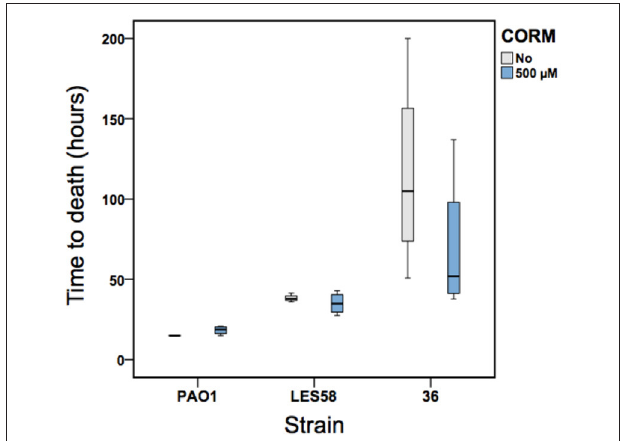
FIGURE 5 | The EBOR-CORM-1 activity against three P. aeruginosa strains in wax moth model. Boxplots show larval survival in the absence (light gray) and presence (blue) of EBOR-CORM-1 for PAO1, LESB58 and clinical isolate #36 (lineage B). Bars show extreme values around lower and upper quartile and black lines show the